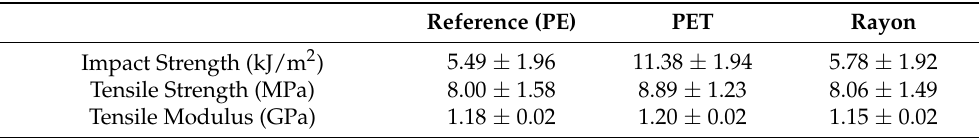
Table 1. The mechanical properties of the composites with standard deviations denoted by standard error.